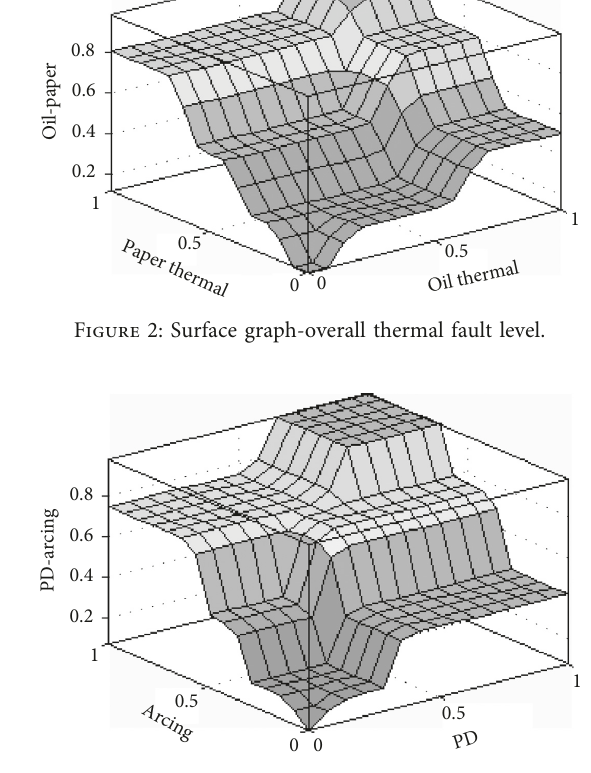
Figure 3: Surface graph-overall electrical fault